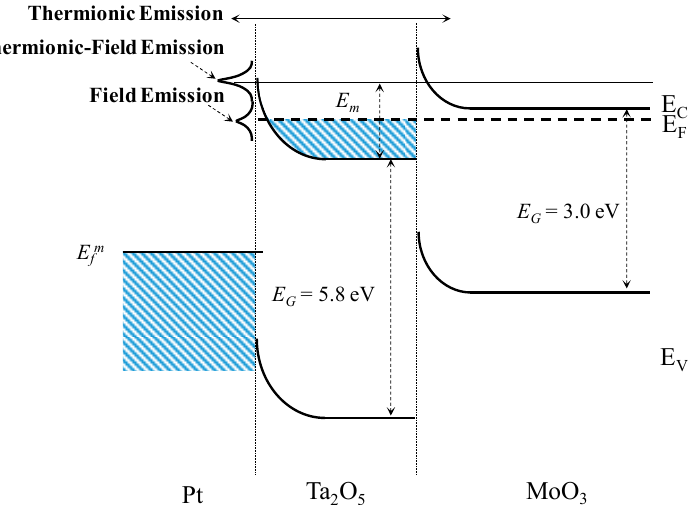
Figure 7. Band diagram of a metal-semiconductor Schottky heterojunction, with dominant transport mechanisms at various energy levels.